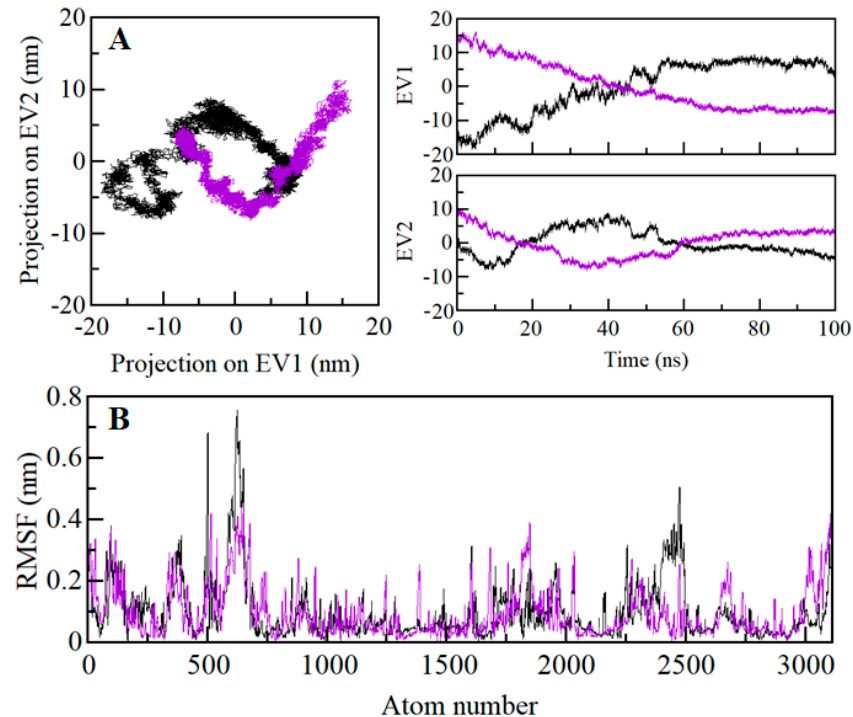
Figure 8. Principal component analysis. ( A ) 2D projections of trajectories on eigenvectors showed different projections of SGK1 (left panel). The projections of trajectories on eigenvectors with respect to time (right panel). ( B ) Atomic fluctuations of SGK1 on eigenvector 1. Black and violet represent the values obtained for free SGK1 and SGK1-ZINC00319000 complex, respectively.